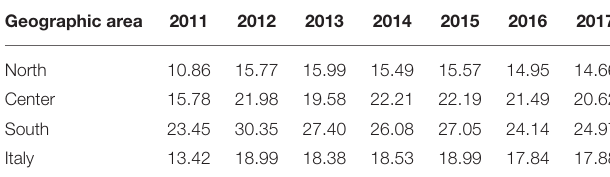
TABLE 2 | Cost of recycling waste (Euro per Kg) (Source: ISPRA). Geographic area